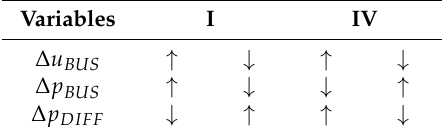
Table 3. Definition of operating regions for MPPT